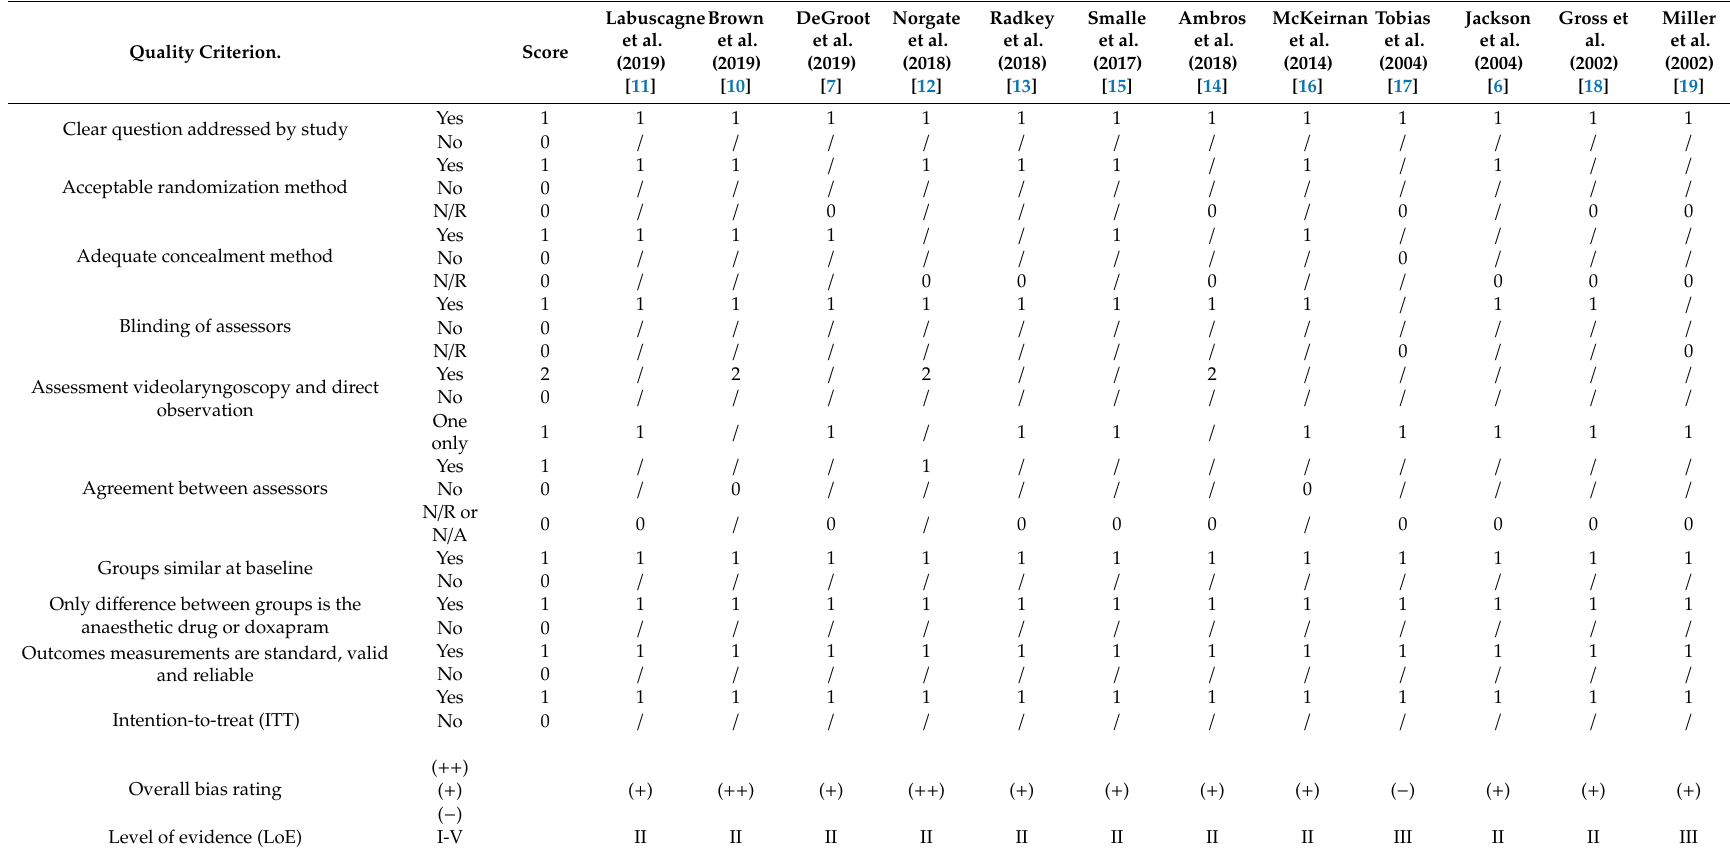
Table 5. Quality assessment of the 12 studies included using the modified SIGN Criteria for RCTs and their assigned levels of evidence (LoE).